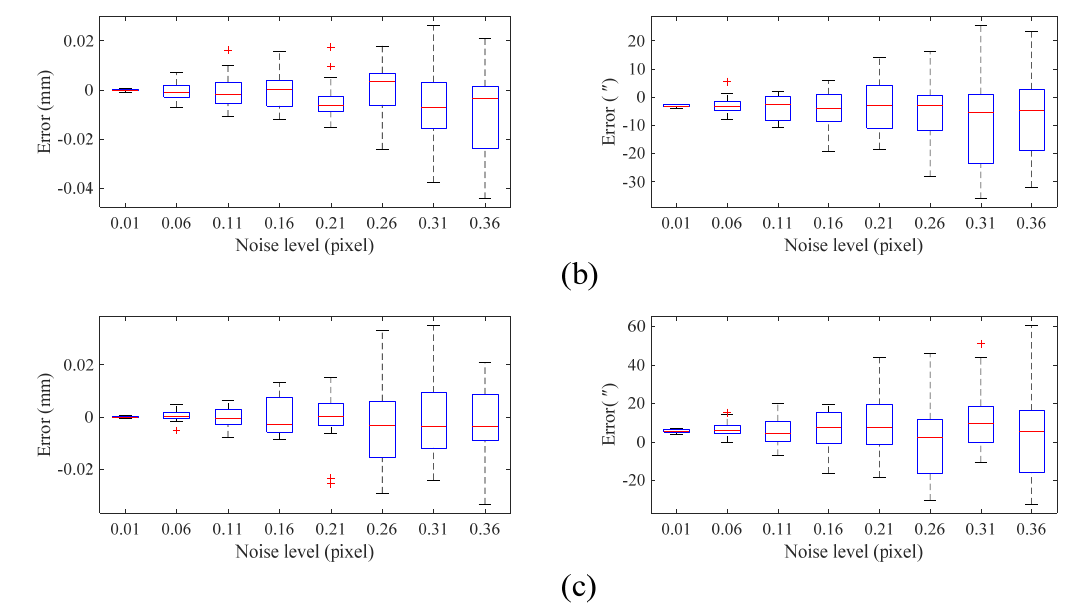
Figure 6. Simulation results for different centroid extraction error levels. Measurement errors in ( a ) the x − axis direction; ( b ) the y − axis direction; ( c ) the z − axis direction.